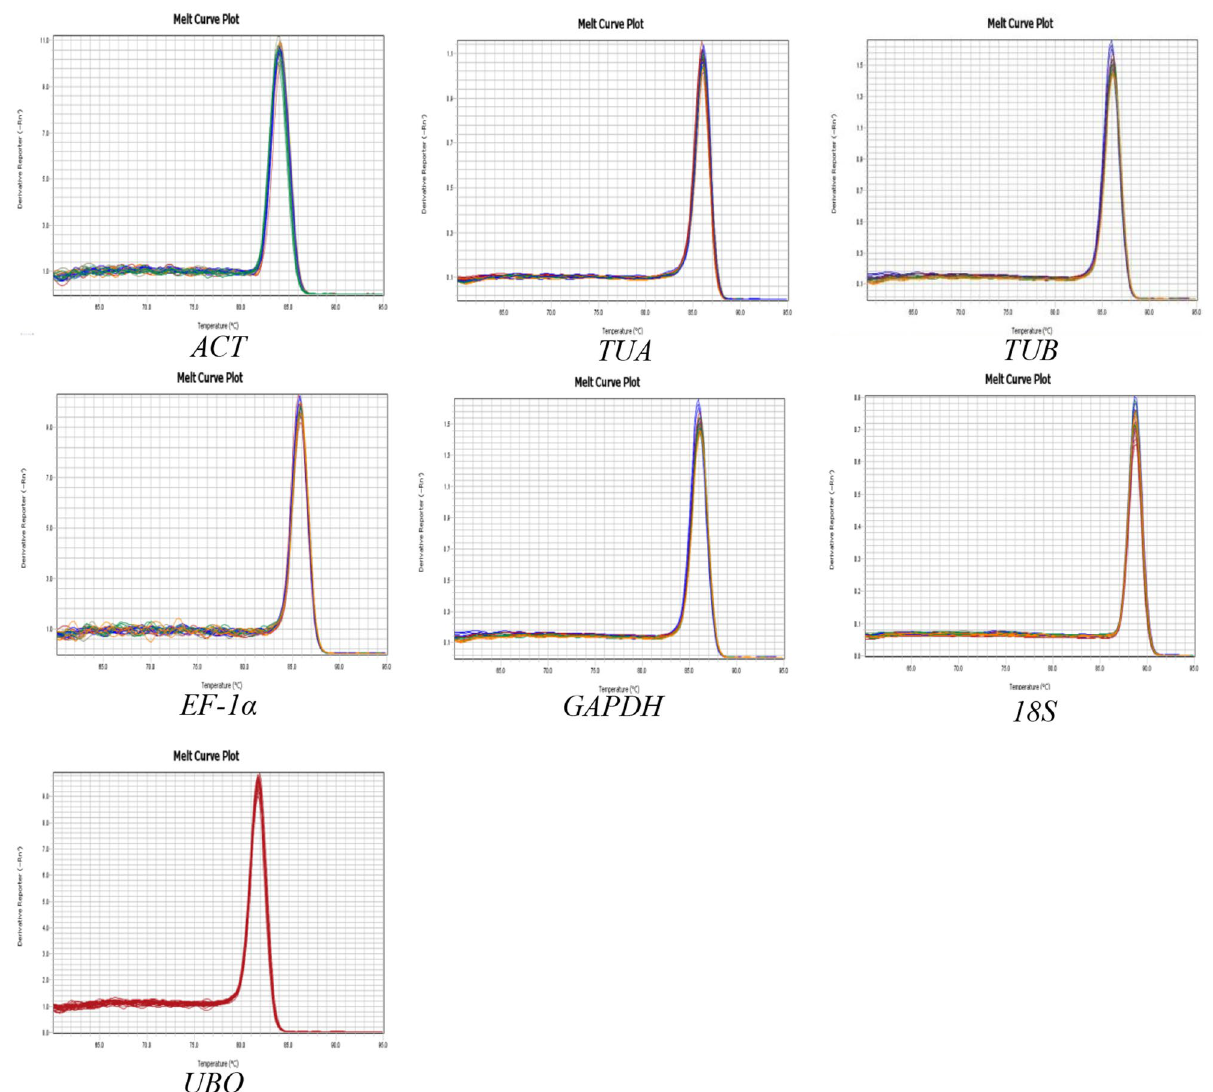
Figure 3. Melting curve analysis of seven reference genes.